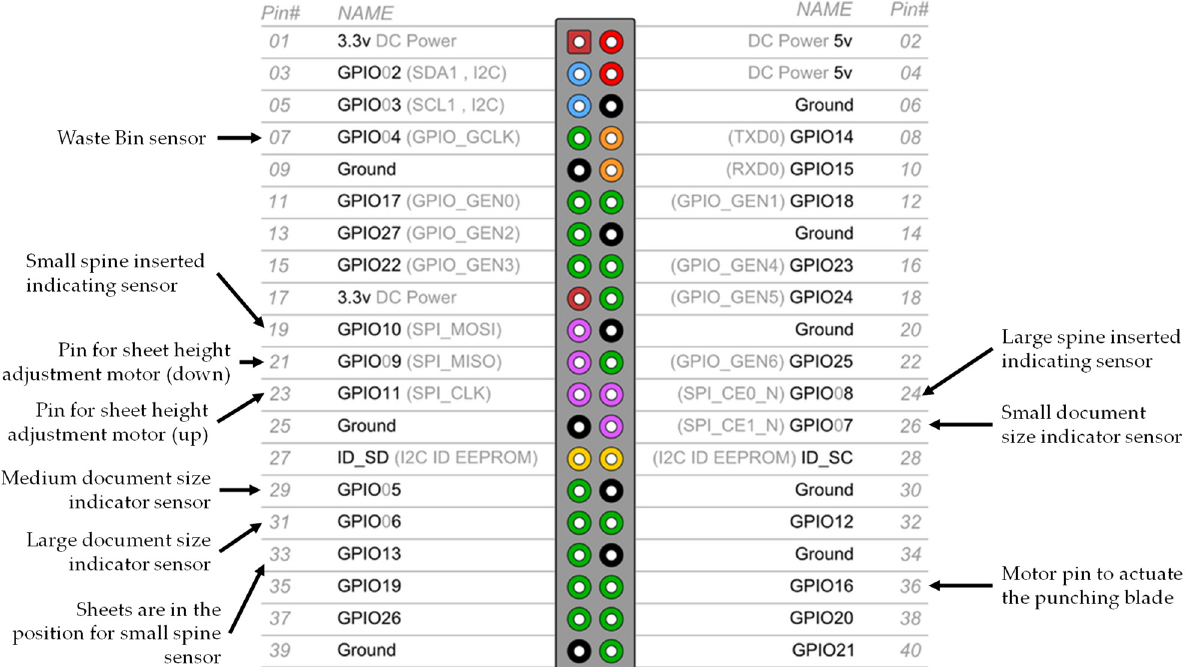
Figure 12. Connection definitions of Raspberry Pi GPIO. Note: Optical sensors and their respective circuits indicate that an object is present when there is NO light transmission between the transmitter and the receiver, by setting its GPIO pin to the low logic level (0 Volts). If there is a problem or a lack of connection with the sensors or their circuits, the GPIO will have the pull-up level. In the case of pull-up to low, it will indicate to the program that the moving parts are interrupting the sensor. In the case of pull-up to high, it will indicate to the program that there is light transmission (even if it does not exist, or in the case of a problem). These GPIOs must be used in situations that do not cause any problems.